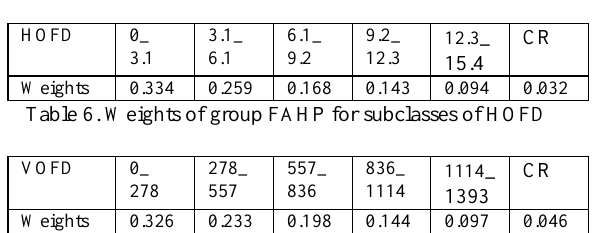
Table 7. Weights of group FAHP for subclasses of